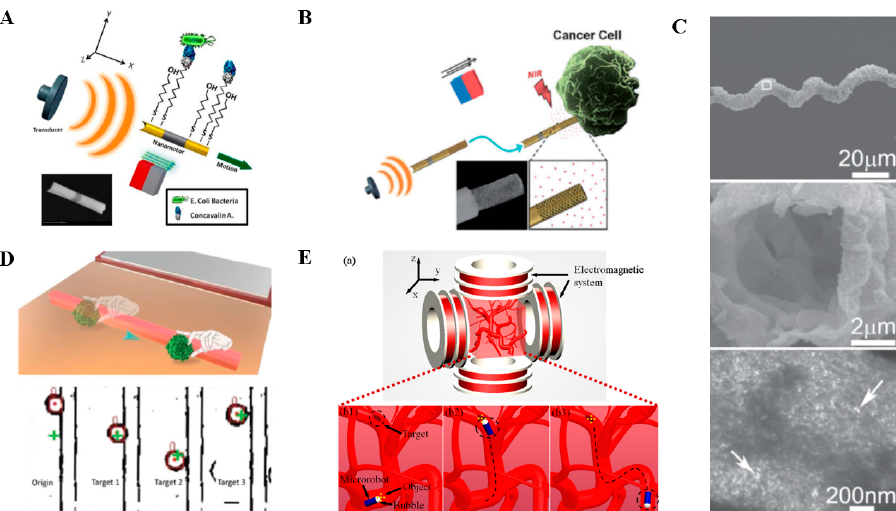
Figure 8. Acoustics-actuated microrobots for targeted drug delivery. ( A ) Ultrasound-propelled magnetically guided nanowire motor for selective capture and transport of biological targets. ( B ) Porous gold nanowire structure for drug loading. ( C ) Structural characterization of the hollow spiral device. ( D ) Precise manipulations of cancer cells based on the vision-feedback control strategy. ( E ) Schematic diagram of micro-object manipulation in blood vessels using a microrobot incorporated